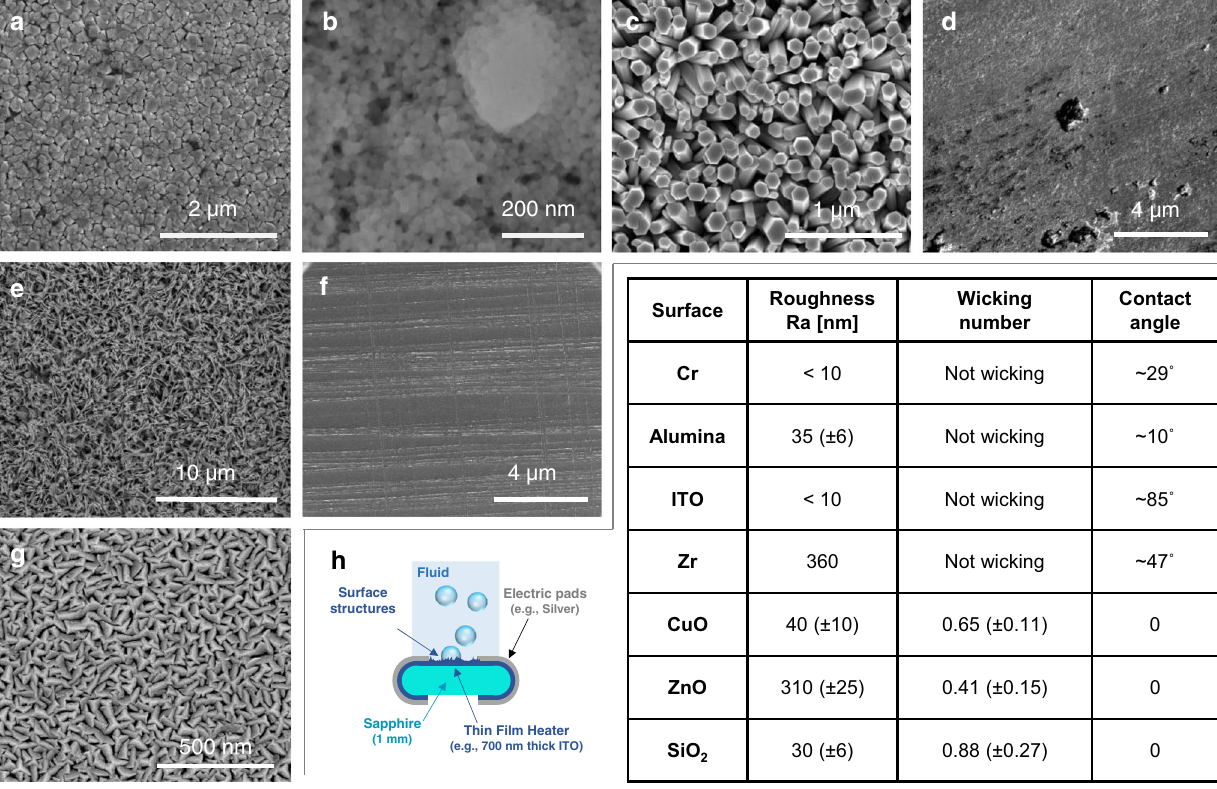
Fig.5|SEMimagesofthesurfacestestedwithwaterandsurfaceproperties.a ITO. b Silicondioxidenanoparticles. c Zincoxidenanowires. d Alumina. e Copperoxide nanoleaves. f Rough zirconium. g Chromium. h Schematic of the heater and measured roughness, wicking number, and contact angle for the tested